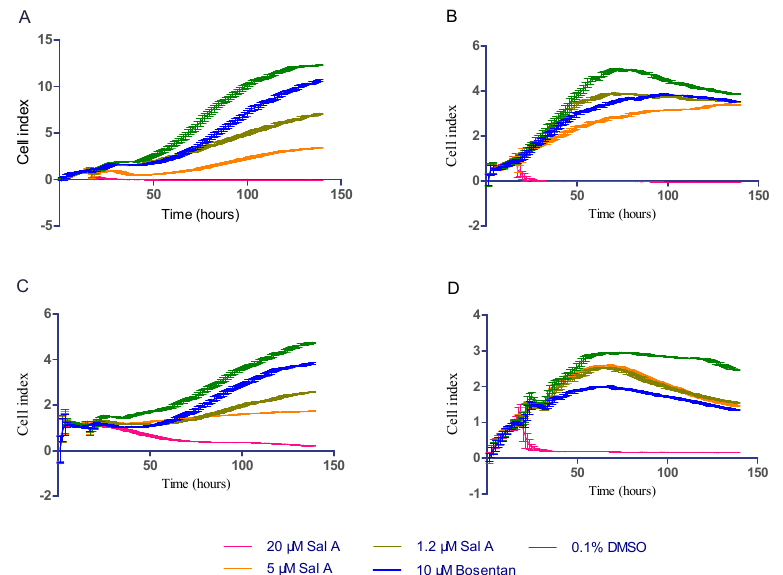
Figure 5. Real-time monitoring of cell proliferation using the xCELLigence system. ( A ) DU145; ( B ) HeLa; ( C ) H1975; and ( D ) A549 cell lines were seeded with 6000 cells per well onto E-plate. After 16 h, cells were cultured in reduced serum medium (2% FBS) in the presence of 20, 5, 1.2 µM Sal A, 10 µM Bosentan, and 0.1% DMSO as negative control. CI was monitored continuously for 130 h. The xCELLigence system was set to record the cell index every 70 min. Data were expressed as mean and SD in two independent experiments.